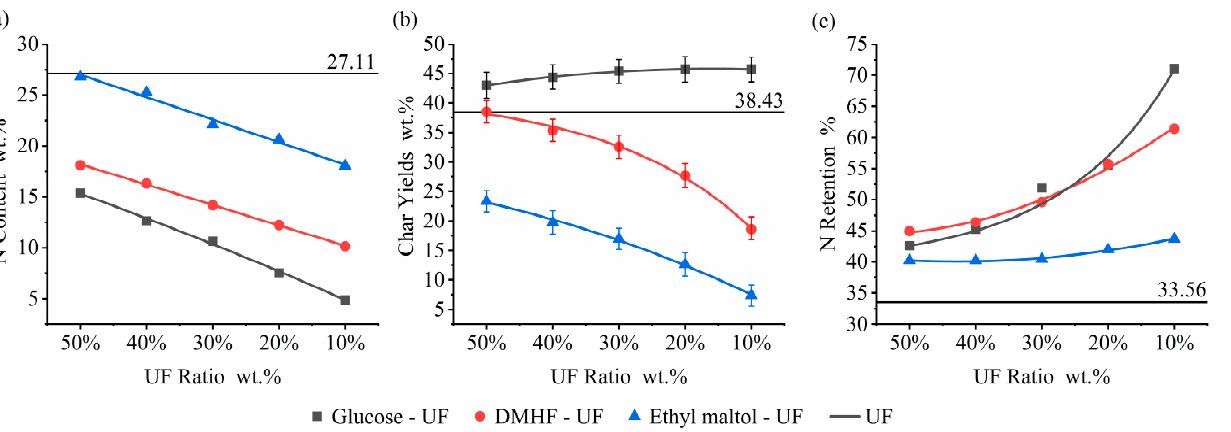
Figure 4. ( a ) Nitrogen content, ( b ) Char yields, and ( c ) Nitrogen retention of chars in model compounds-UF chars.